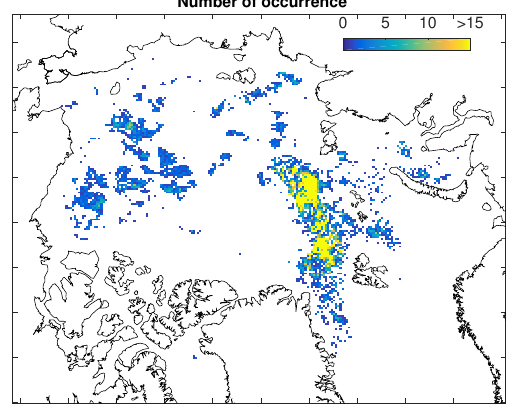
Figure 2. Number of occurrence of free drift events identified be- tween 31 October 2007 and 28 April 2008 and selected for the op- timisation of the air drag